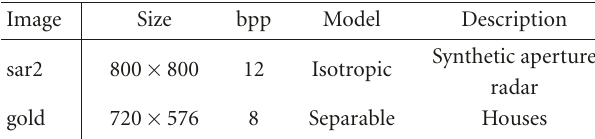
Table 5: Small subset of test